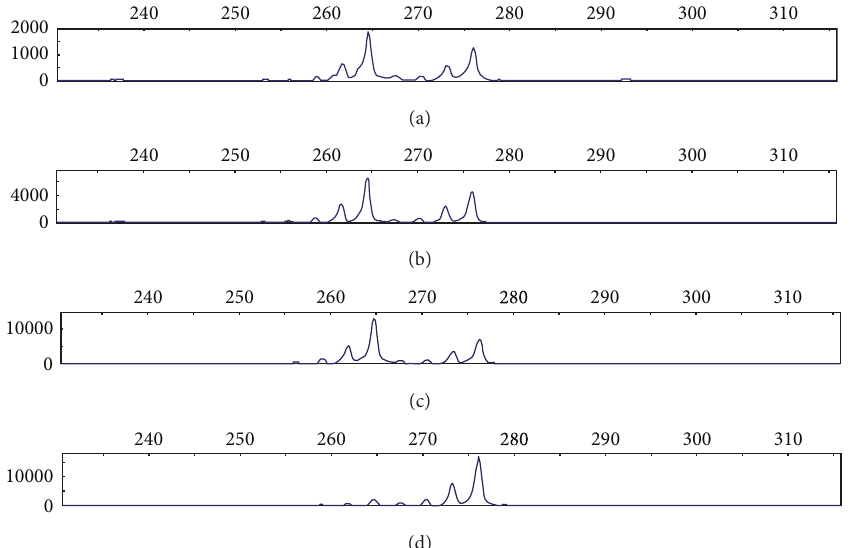
Figure 2: HUMARA analysis. The panels show size-separation of PCR products by capillary electrophoresis. The 𝑥 -axes show the sizes in base pairs and the 𝑦 -axes the fluorescence activity. Each peak corresponds to one allele of the amplified microsatellite. Controls (a) and (b): random methylation pattern: no difference observed between the undigested sample (a) and digested sample (b). Patients (c) and (d). (c) Genomic DNA: two alleles are visible at 264 and 276 base pairs. Semiquantitative PCR showed that the 264-base pair allele was located on the idic(X)(q13), visible as a peak height ratio of 1.86. (d) After digestion, only the 276-base pair peak was present, showing that the isodicentric chromosome was